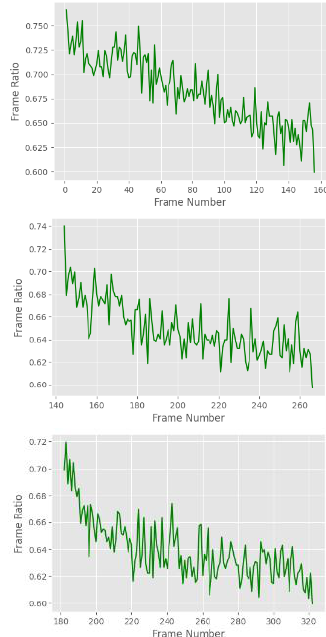
Figure 7. The calculation of the corresponding ratio coefficient between the frames